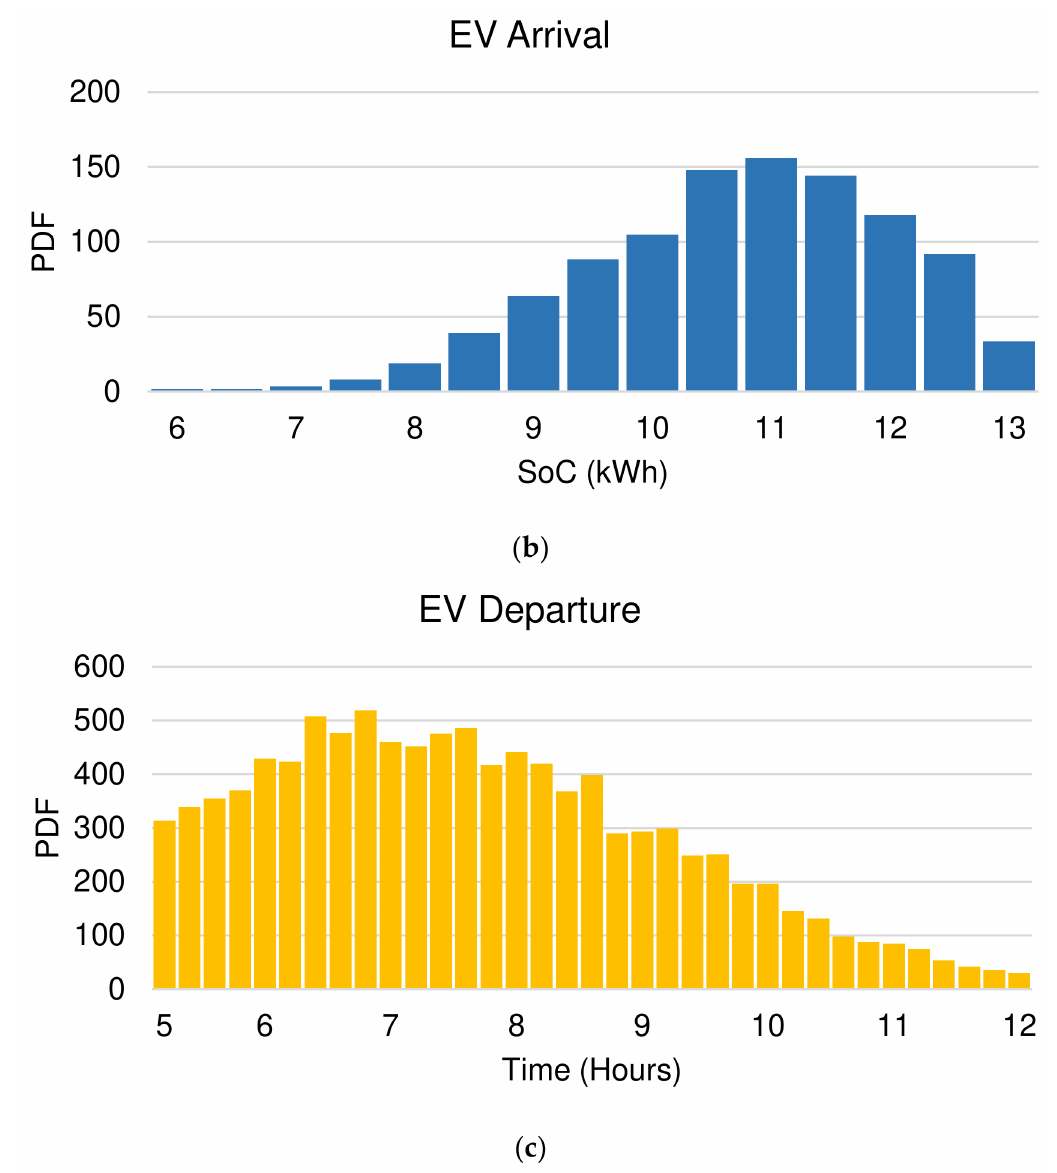
Figure 10. Normal distribution of EV: ( a ) of arrival; ( b ) EV arrival time, and; ( c ) EV departure time.